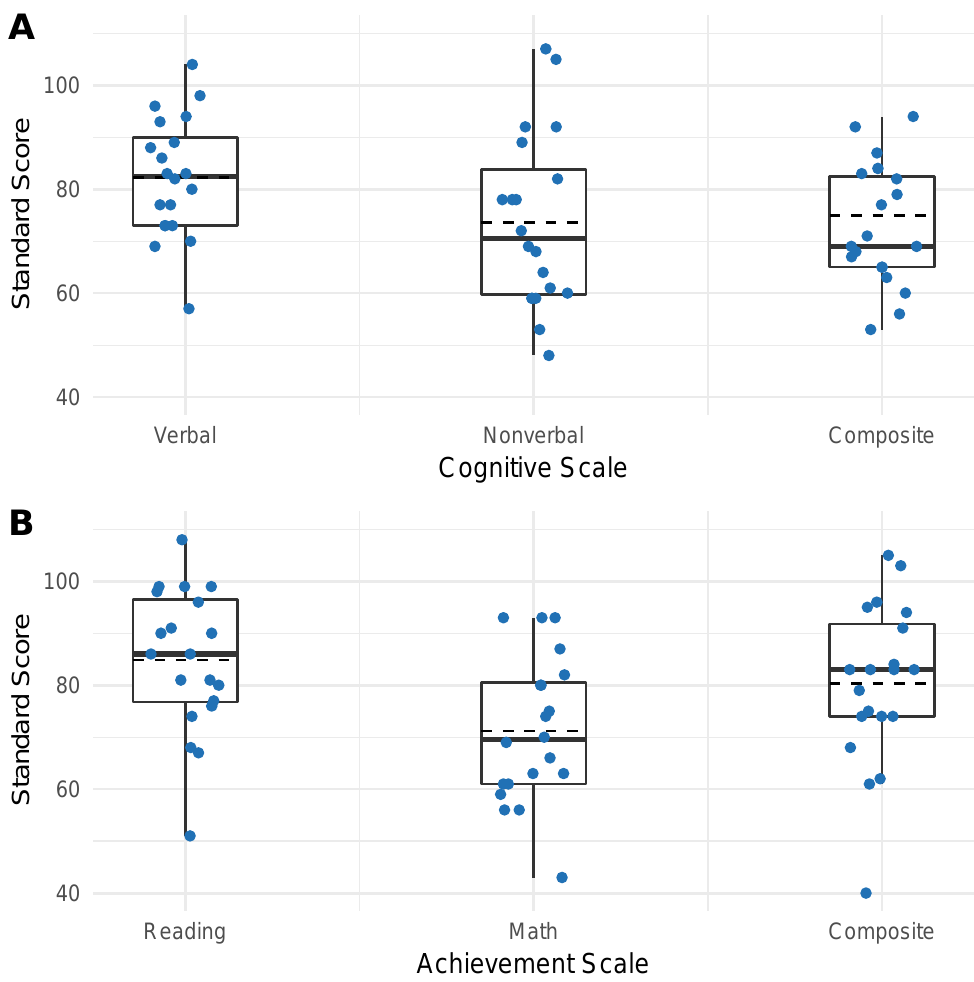
Figure 2. Cognitive and achievement score profiles. Each dot indicates a participant, solid horizontal line represents median, dashed horizontal line represents mean, box represents interquartile range, and vertical lines upper and lower extremes (excluding outliers). ( A ) Distribution of participant cognitive scores on verbal, nonverbal, and overall composite of the Differential Ability Scales, 2nd Edition (DAS-II). ( B ) Distribution of participant achievement scores on reading, math,